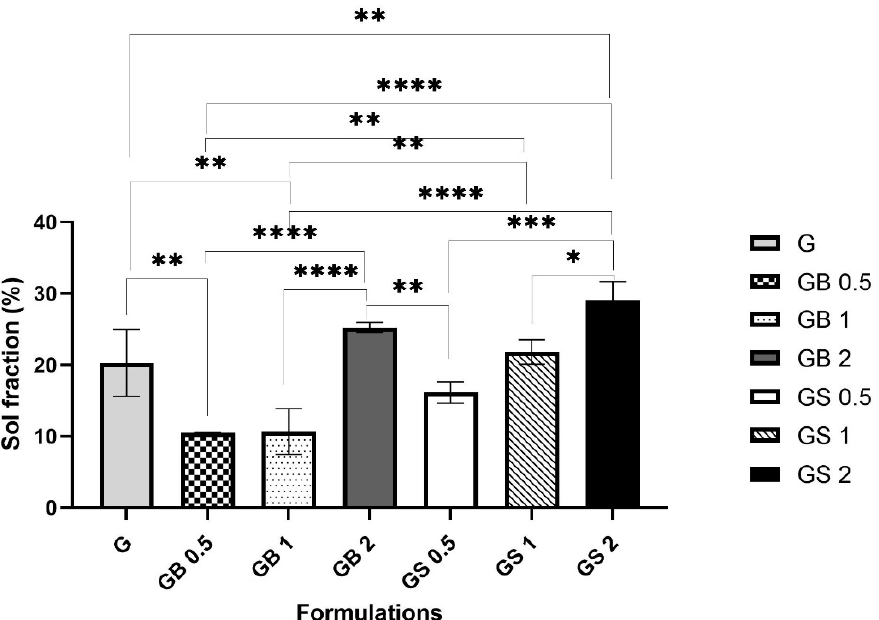
Figure 5. Comparison of sol fraction (%) between the meshes of different formulations. (**** p < 0.0001, *** p < 0.001, ** p < 0.01, * p < 0.05).